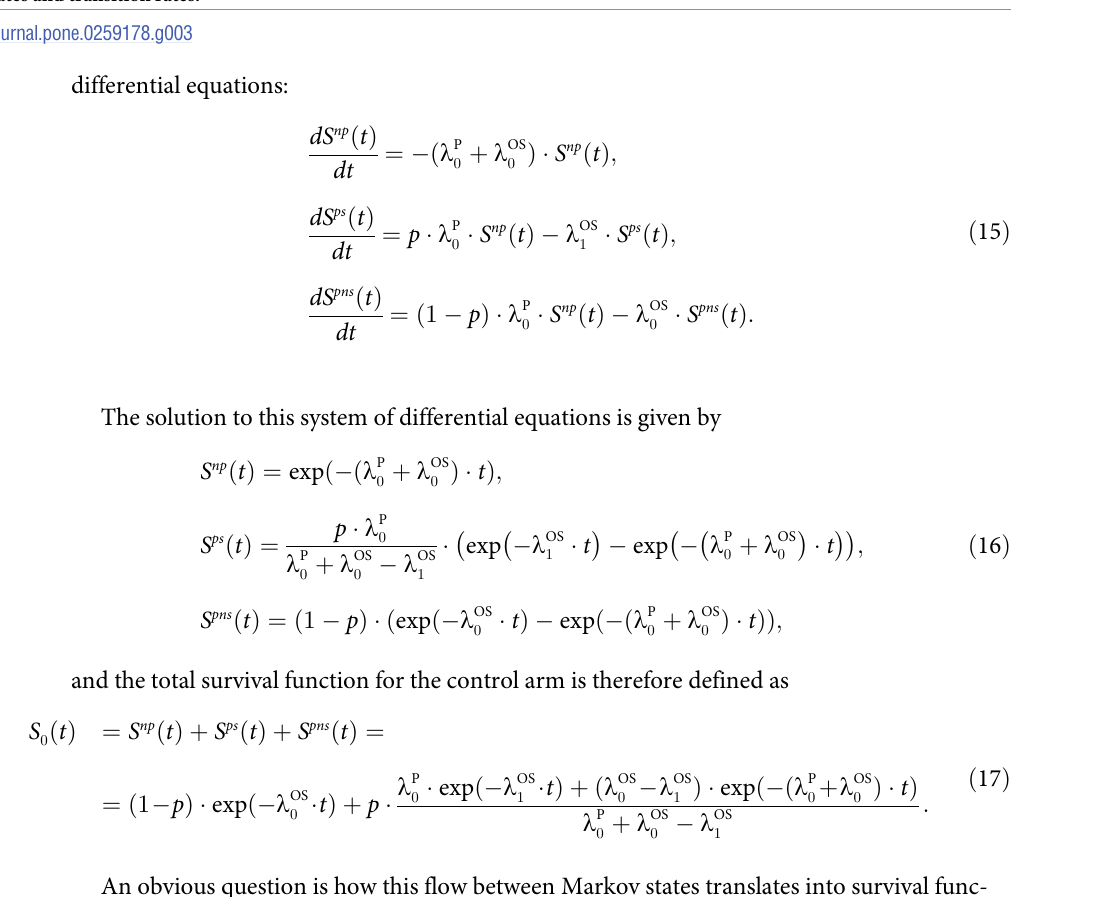
Fig 3. Markov chain states and transition